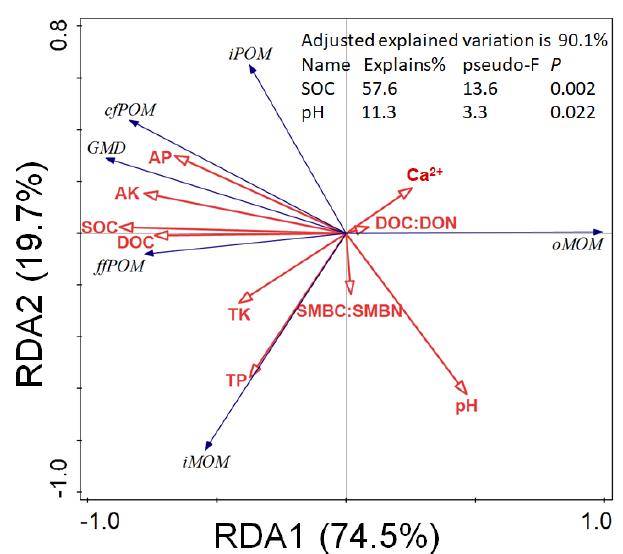
Figure 6. RDA analysis of aggregate distribution and soil properties. cfPOM means coarse free particulate organic matter fraction, iMOM means mineral-associated organic matter inner microaggregate, and MOM means mineral-associated organic matter fraction. Abbreviations: TN, total nitrogen content; SOC, soil organic matter; DOC, dissolved organic carbon; DON, dissolved organic nitrogen; SMBC, soil microbial biomass carbon; SMBN, soil microbial biomass nitrogen; TK, total potassium; AK, available potassium; TP means total phosphorus; AP, available phosphorus.